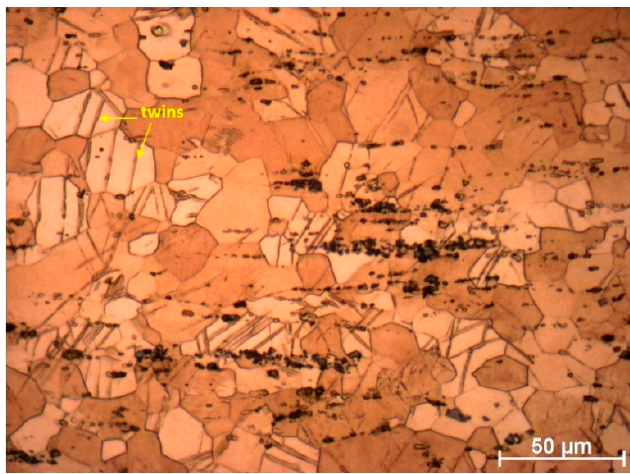
Figure 8. Optical microstructure close to the tensile fractured regions of Mg-2Zn-0.6Ca-1Er .